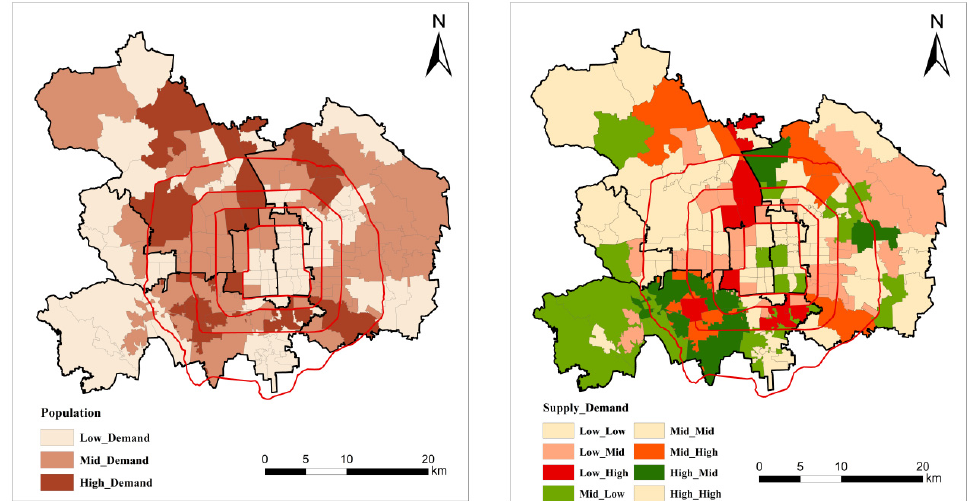
Figure 6. The total population’ spatial distribution pattern in sub-districts ( left ); Spatial matching of the sub-district’s TPS to the demand of total population within the sub-district ( right ).